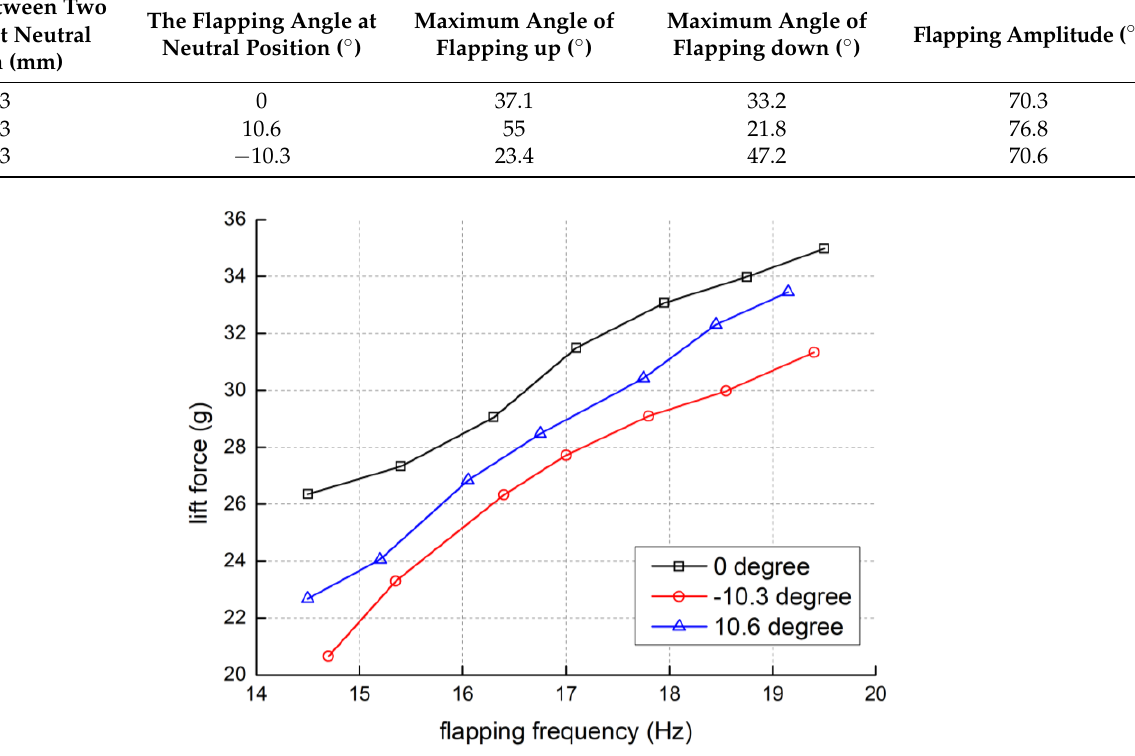
Figure 18. The flapping frequency-lift force line chart of the FWR with different neutral